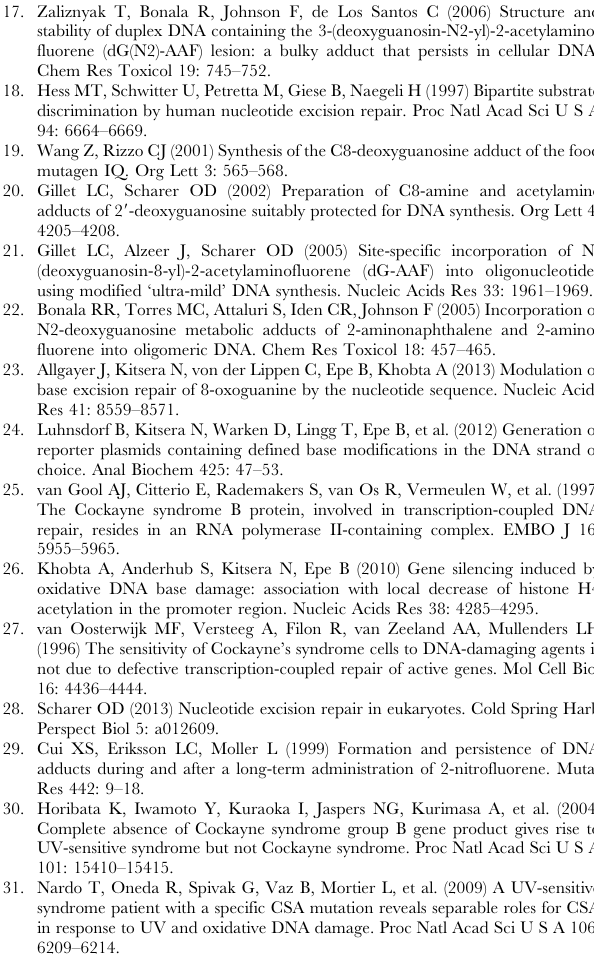
strand. Dot density plots obtained in a representative experiment and the corresponding overlaid fluorescence distribution plots. Extended data for the experiment shown in Figure